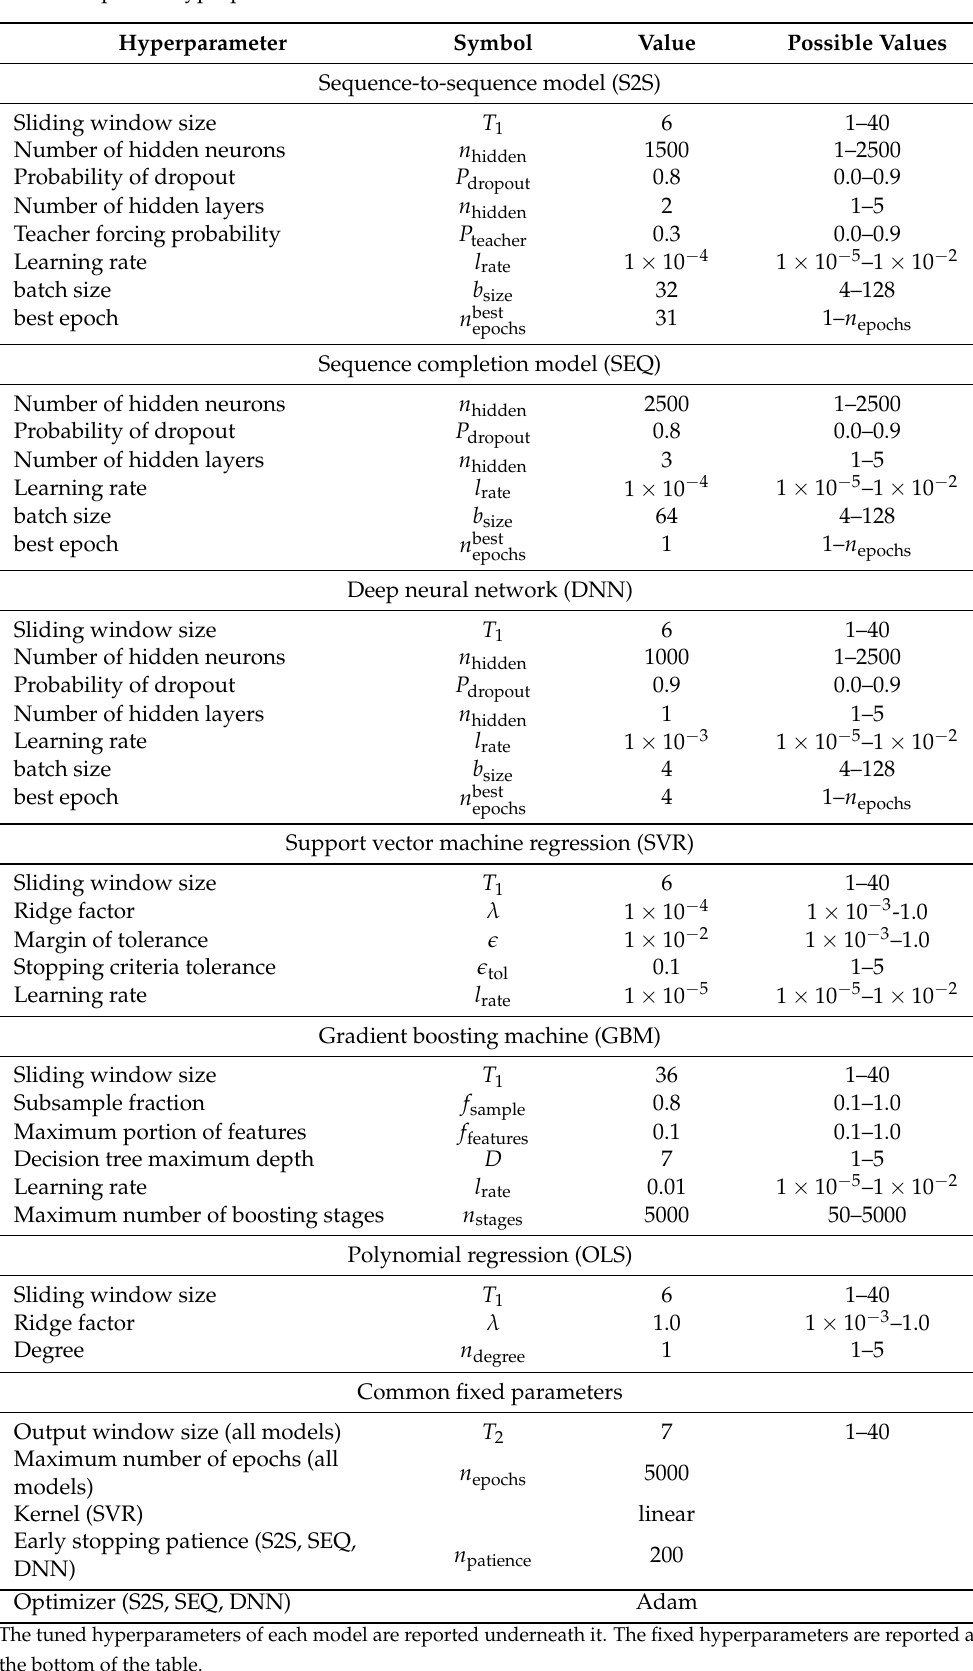
Table 1. Optimal hyperparameters of different